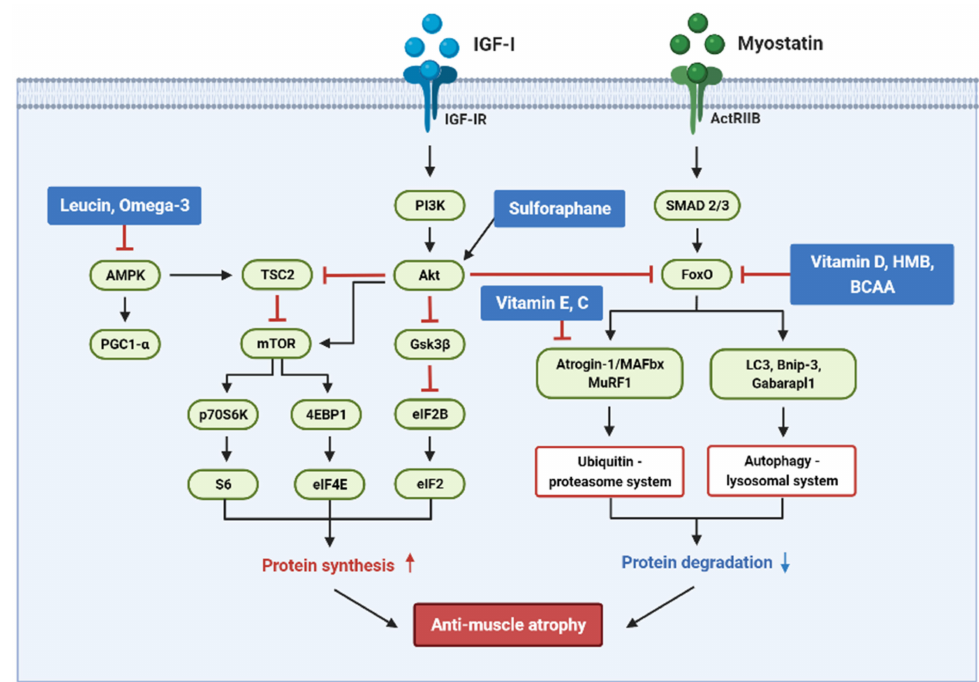
Figure 2. Anti-muscle atrophy signaling pathway regulated by multiple nutrients in a glucocorticoid- induced muscle atrophy model. The figure shows the major pathways that help maintain muscle protein turnover rate by inducing protein synthesis and inhibiting protein